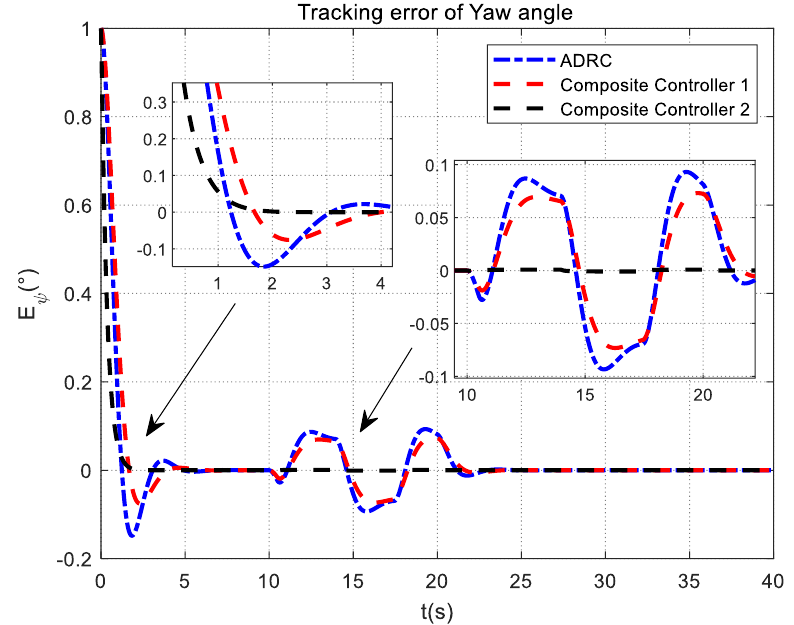
Figure 24. Tracking error of Yaw angle control for QUAV under actuator time-varying fault and disturbance condition.